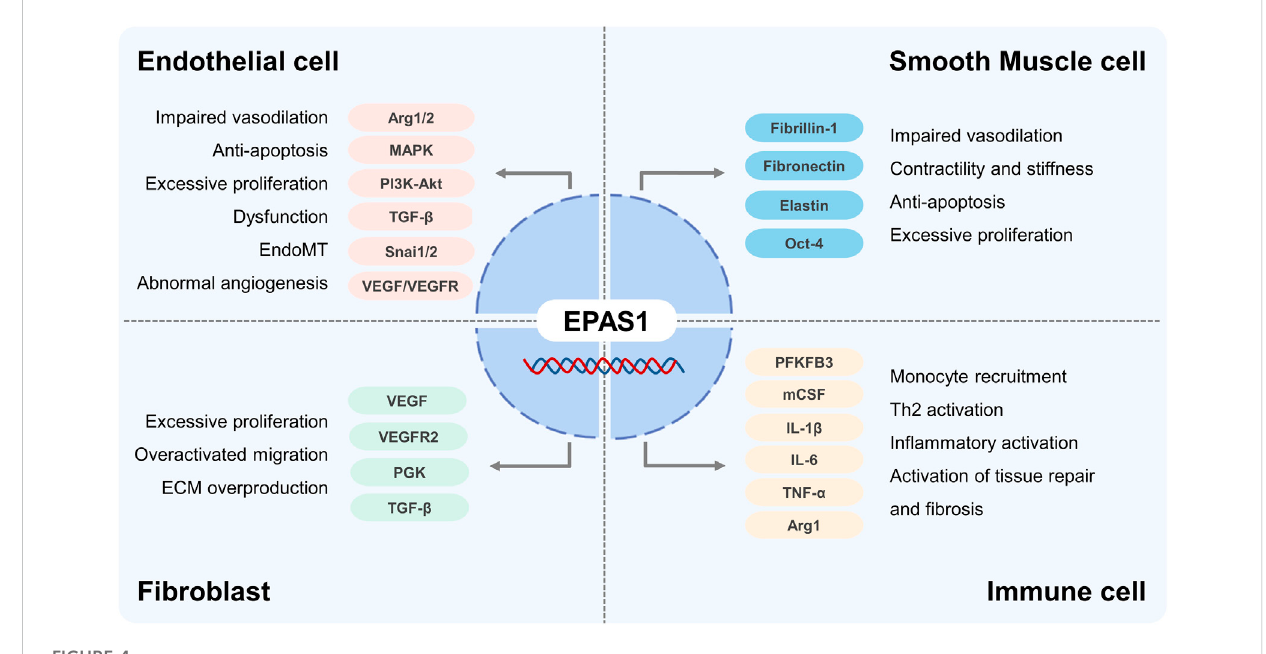
FIGURE 4 The role of EPAS1 in Pulmonary